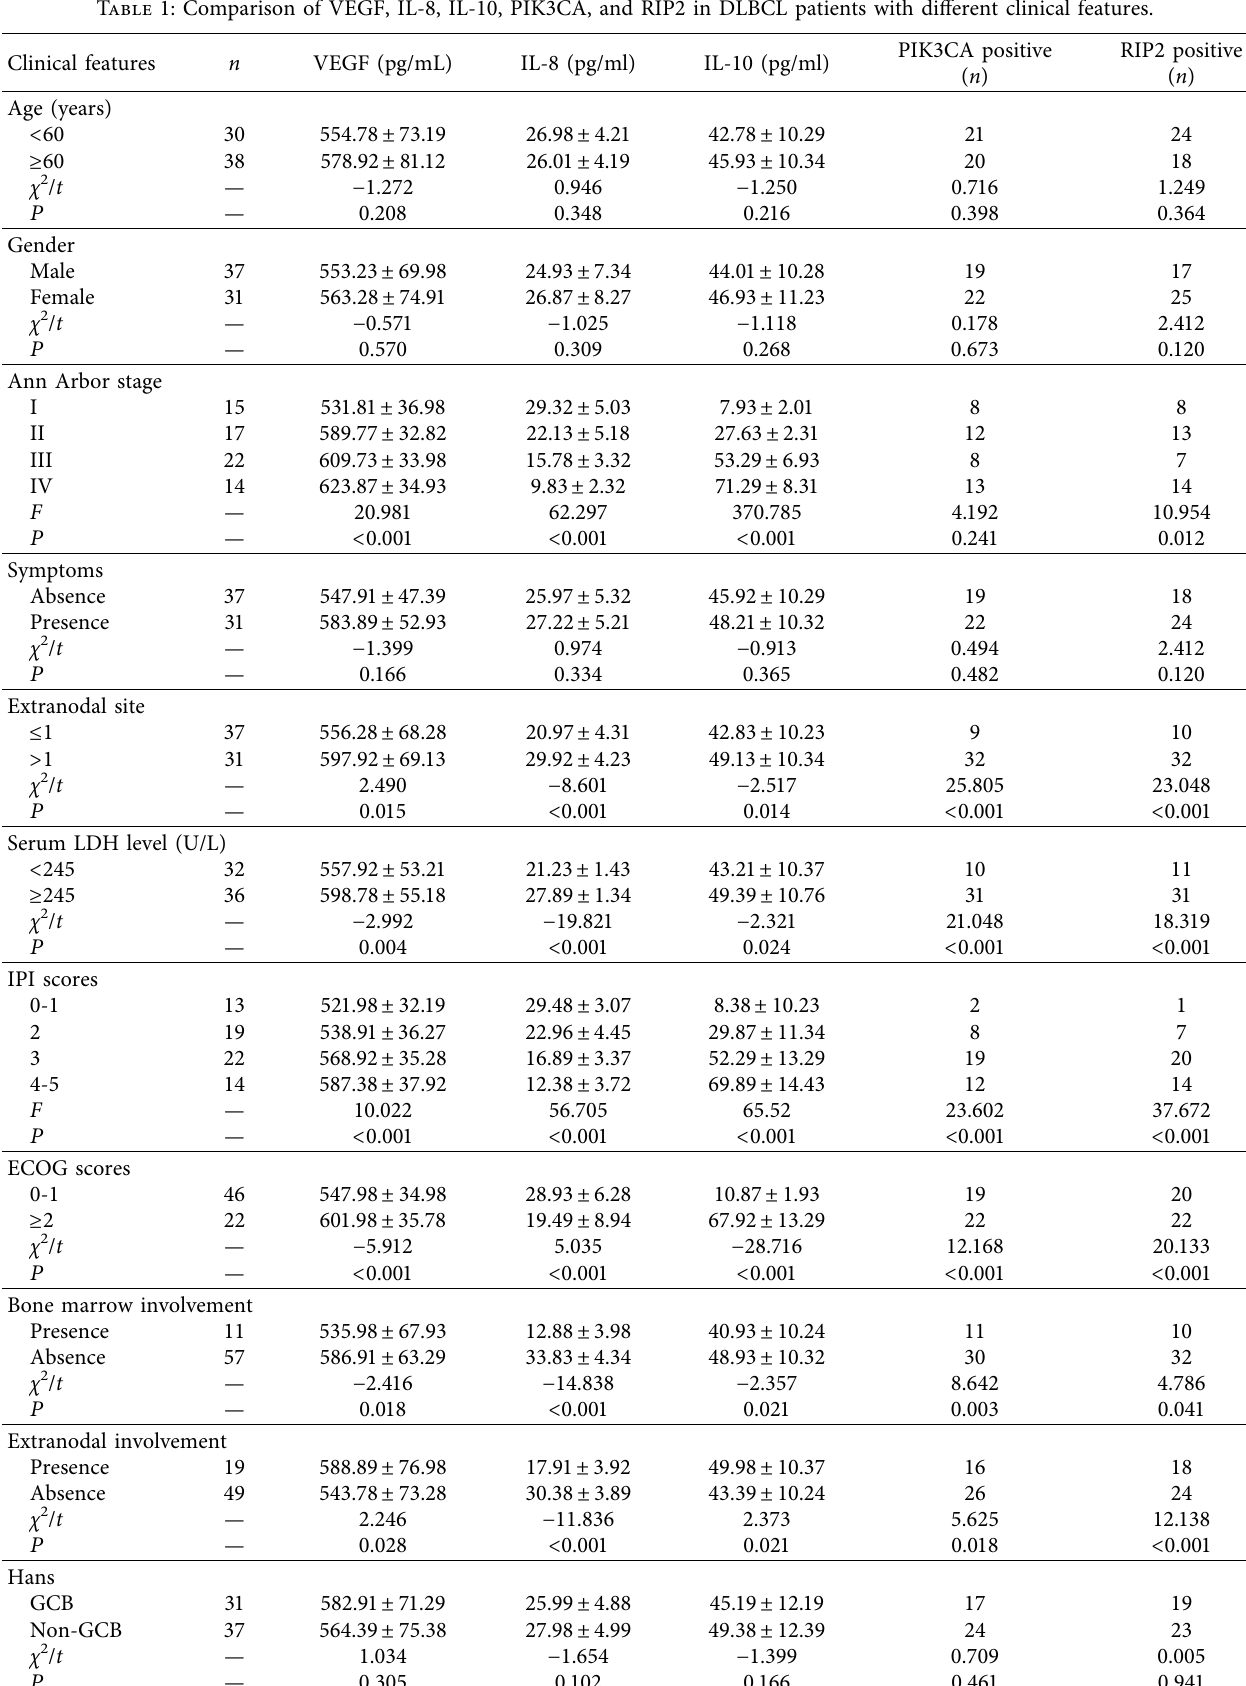
Table 1: Comparison of VEGF, IL-8, IL-10, PIK3CA, and RIP2 in DLBCL patients with diferent clinical features. Clinical